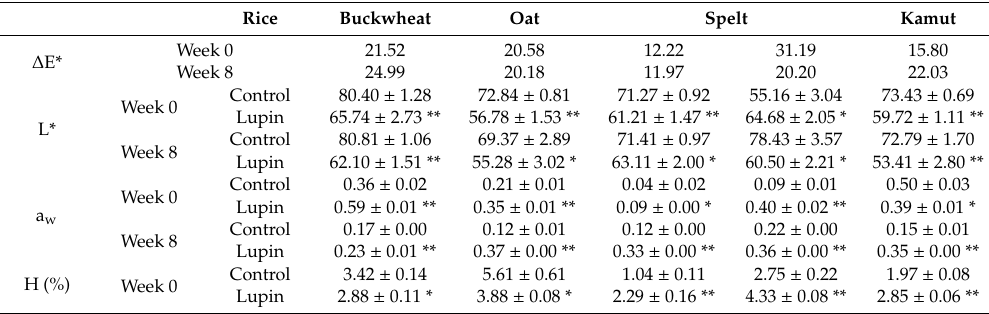
Table 4. Values of ∆ E*, L*, a w and the moisture content (H, % w / w ) of the control and lupin-enriched cookies. Values are the means of at least three experiments ± SD, except ∆ E* which is the di ff erence between the control and lupin-enriched cookie colors. * represents p < 0.05 and ** represents p < 0.001 when compared with the corresponding control cookie. Rice Buckwheat Oat Spelt Kamut ∆ E* Week